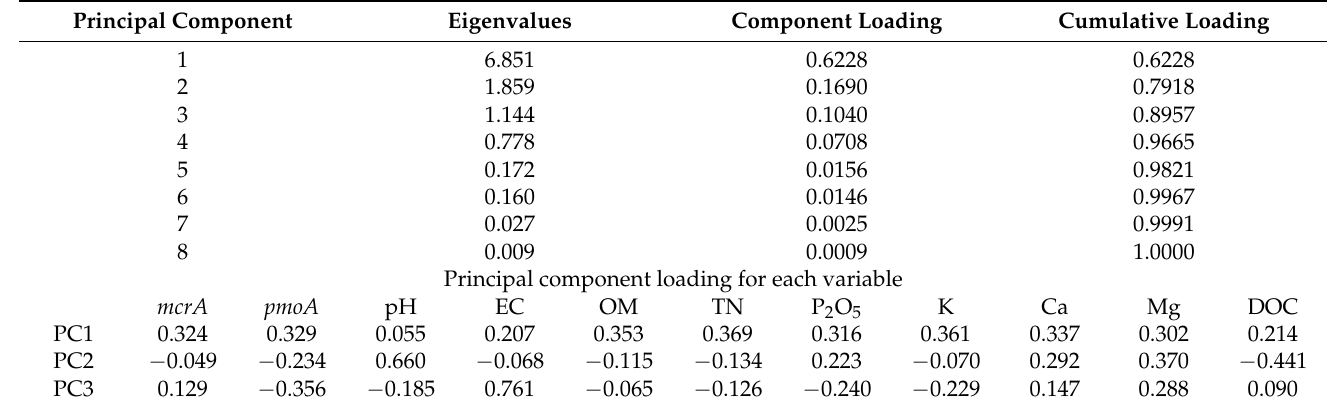
Table 3. Principle component analysis of methane cycling related functional gene abundance and soil chemical properties and their loading coefficient for the principal